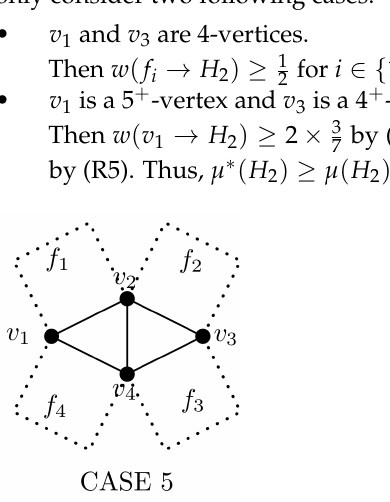
Figure 2. The configuration in CASE